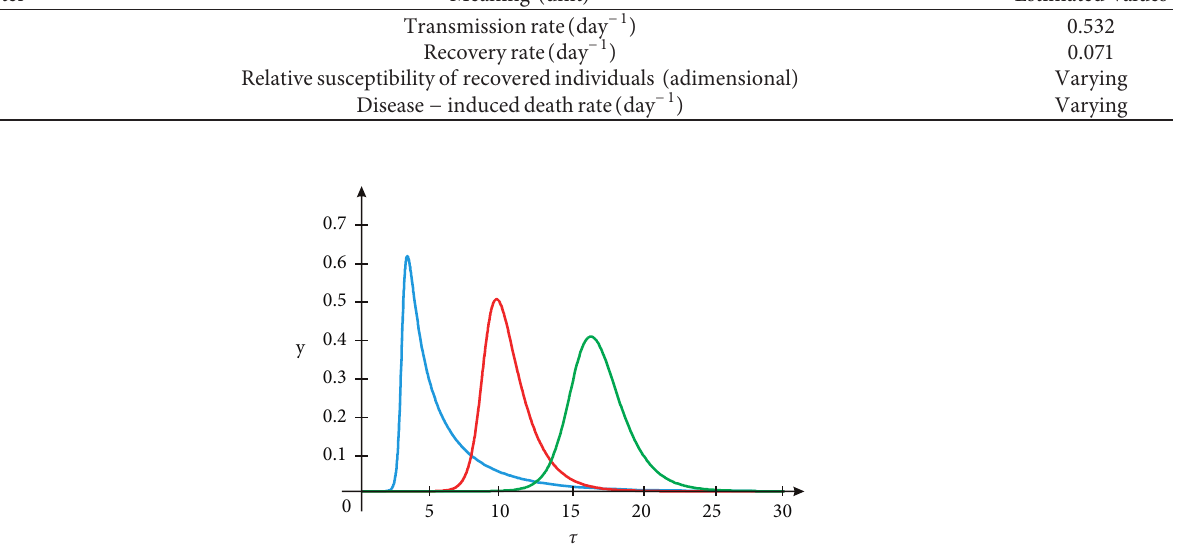
Table 1: Estimation of the values of the main parameters used in the model, which correspond to the SARS-CoV-2 coronavirus. Parameter